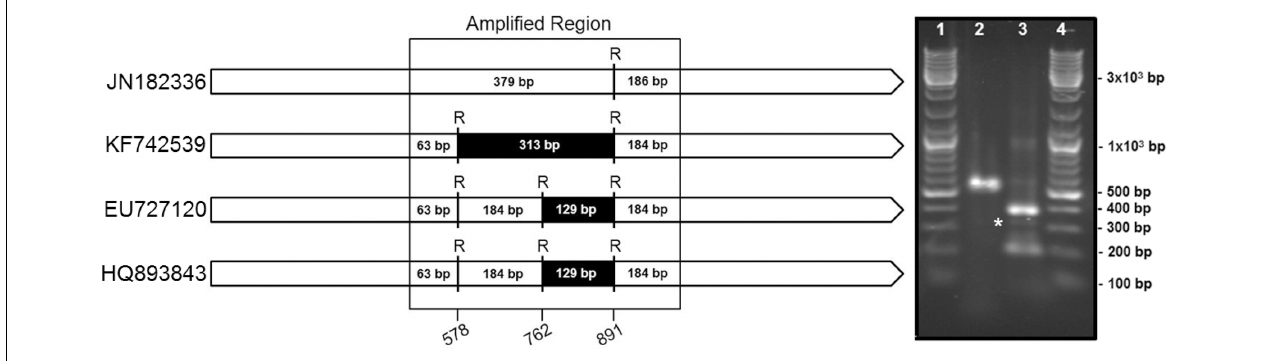
fragments length are shown. Position numbers refer to the E. coli homolog. Right panel : RFLP results. Lanes 1 and 4, Molecular Weight Marker; lane 2, undigested amplicon; line 3, amplicon digested with Rsa I. A band around 313bp (labeled with an asterisk) is indicative of the